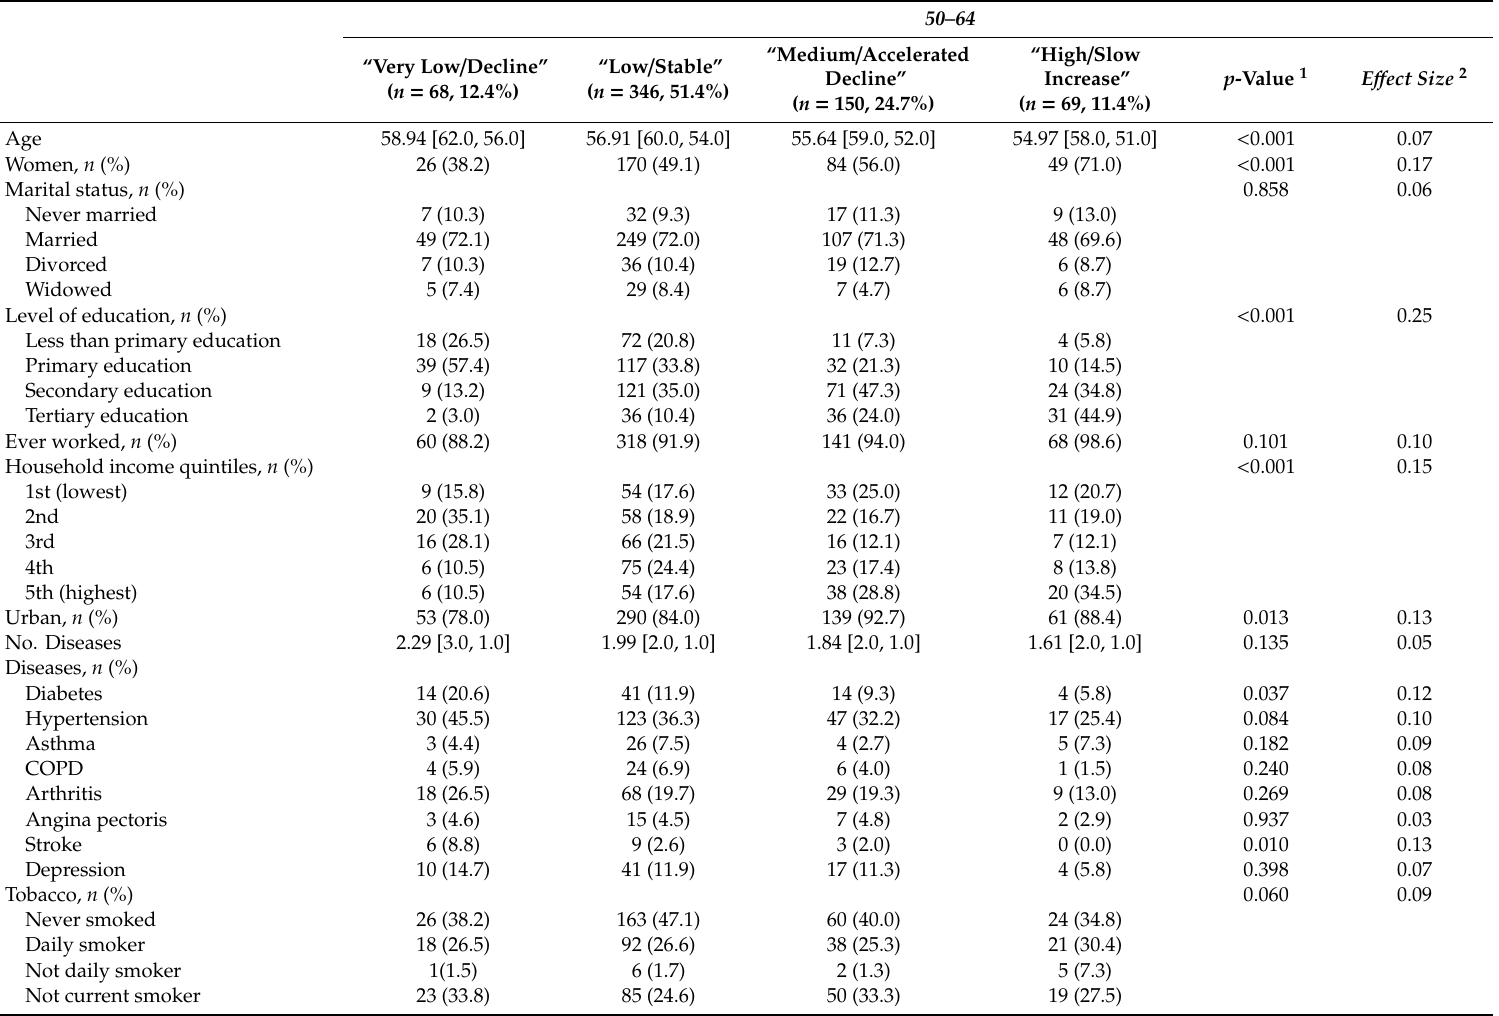
Table 5. Comparison of sociodemographic and clinical characteristics between delayed verbal memory trajectories in the 50–64